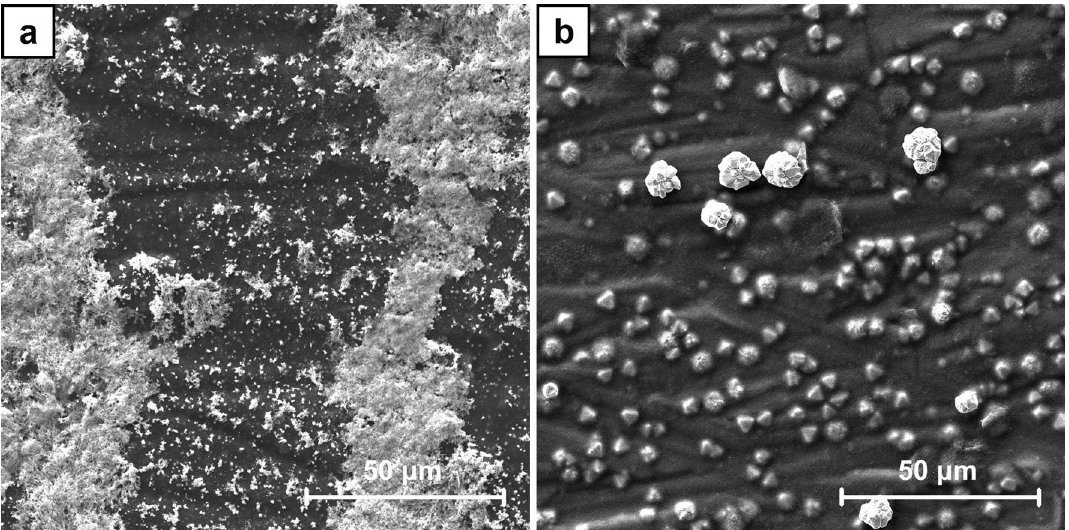
Figure 2. The comparison of SEM images of A7 sample (ECD deposition time of 600 s, CuSO 4 concentration of 1 mM) ( a ) and B7 sample (ECD deposition time of 600 s, CuSO 4 concentration of 100 mM) ( b ) at the magnification of ×2000.